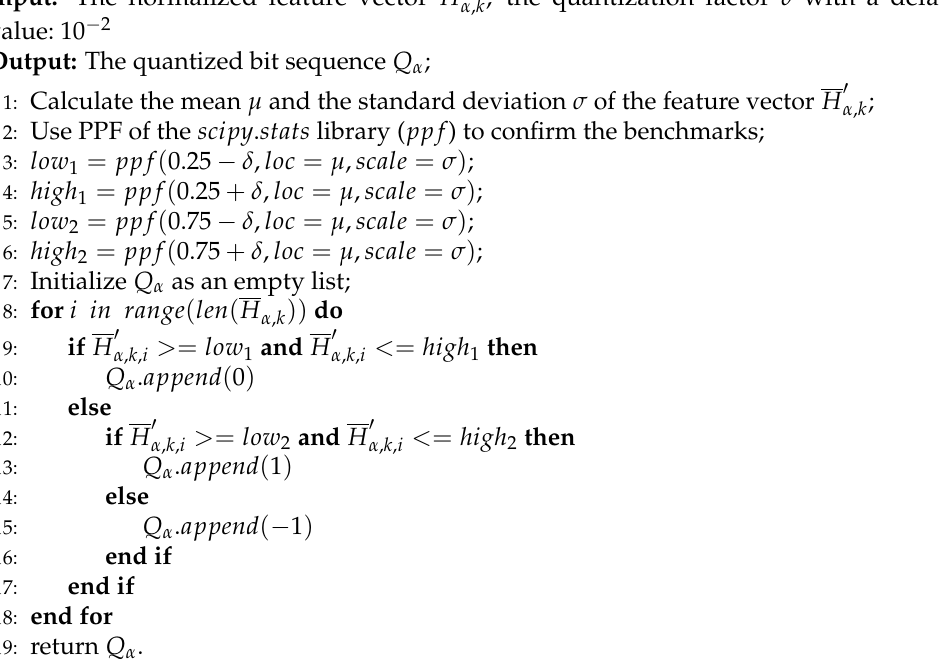
Algorithm 1 The multi-level quantization algorithm based on PPF